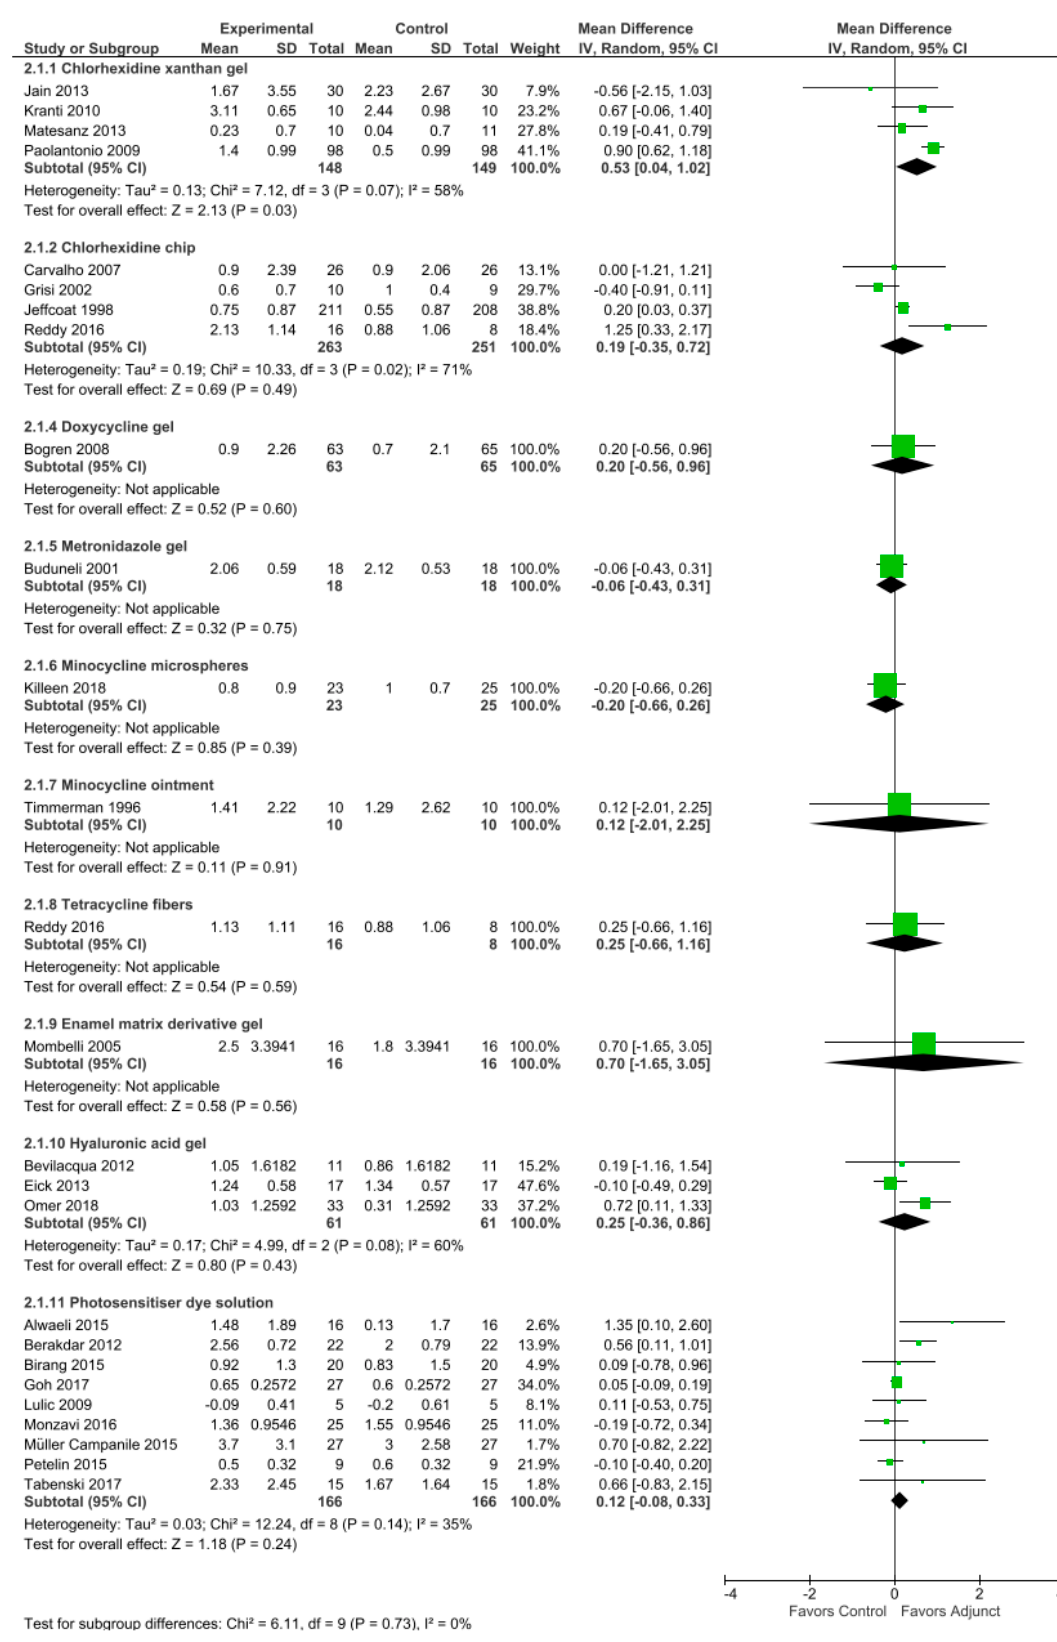
Figure 4. Meta-analysis of studies on changes in clinical attachment level (CAL) for control (mechanical debridement alone) versus use of adjuncts, sub-grouped by agent, based on random effects model; mean difference in units of millimeters.